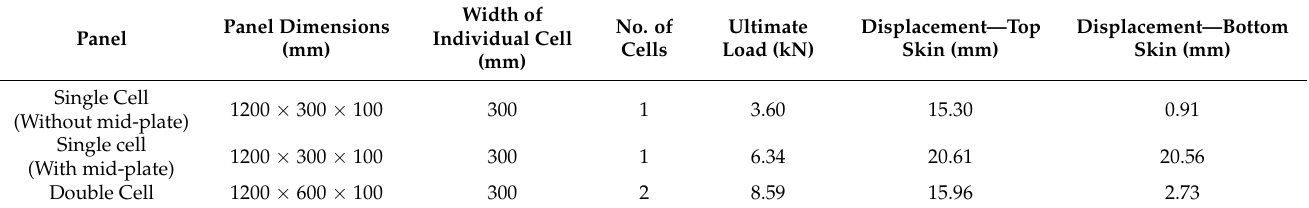
Table 4. Comparison of average load vs displacement values for single cell and double cell panels.